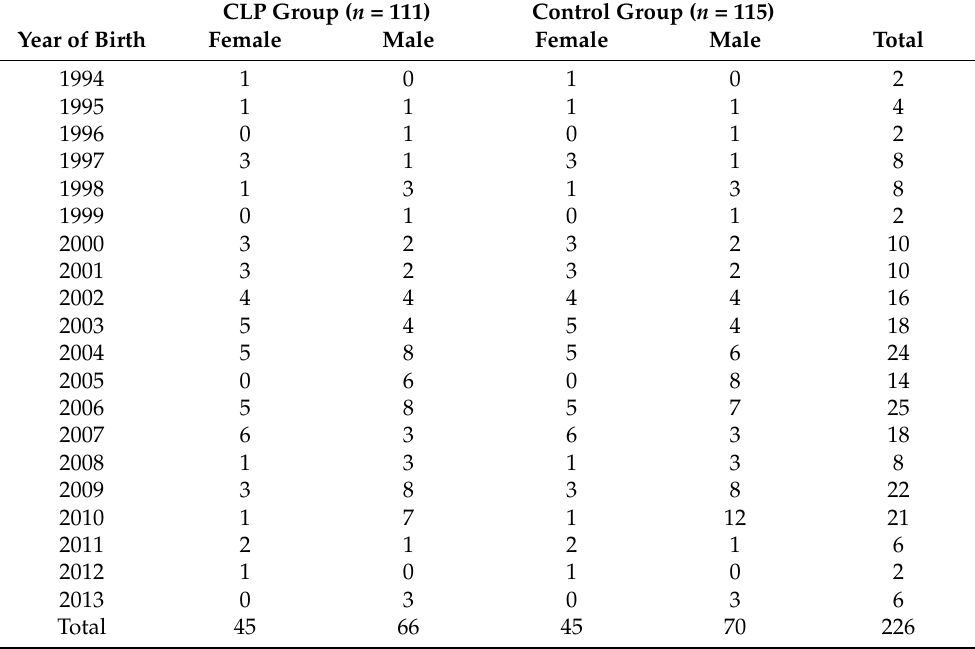
Table 1. Age and sex by each